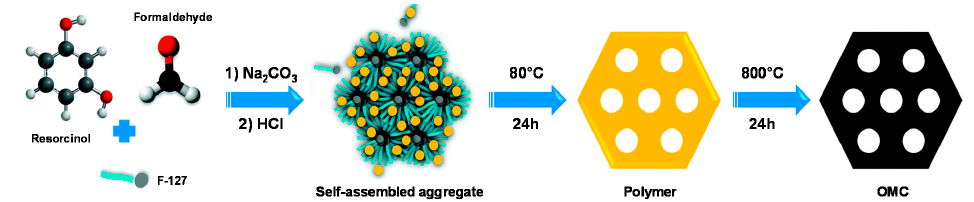
Figure 2. Schematic description of the soft template route to OMC using resorcinol-formaldehyde as carbon source and F127 as copolymer template (adapted from [37]).